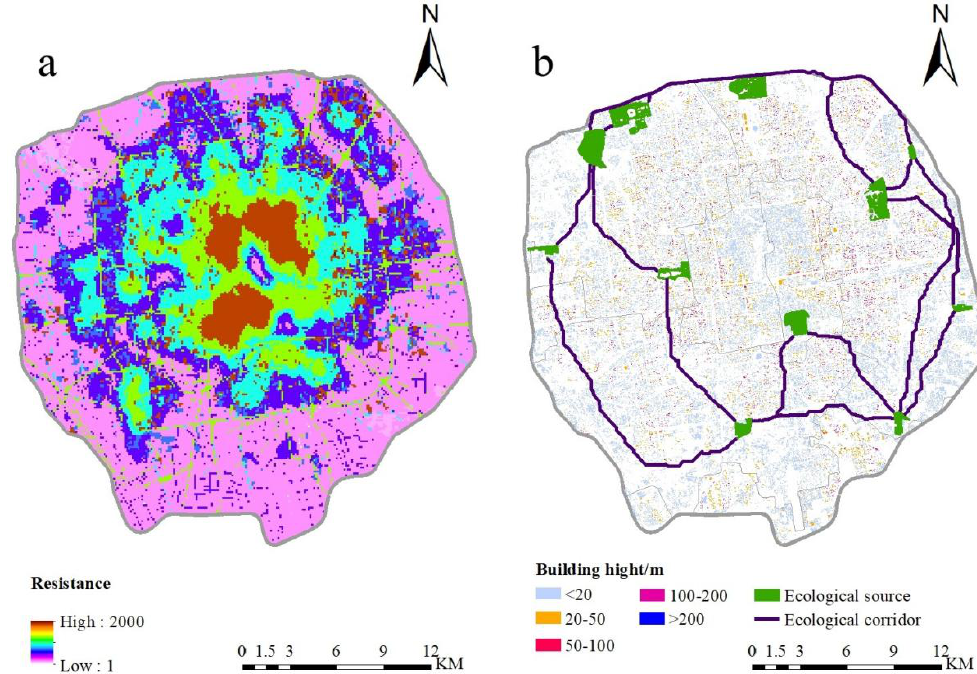
Figure 6. Three-dimensional EN. Note: ( a ). 3D resistance surface; ( b ). ecological corridor.